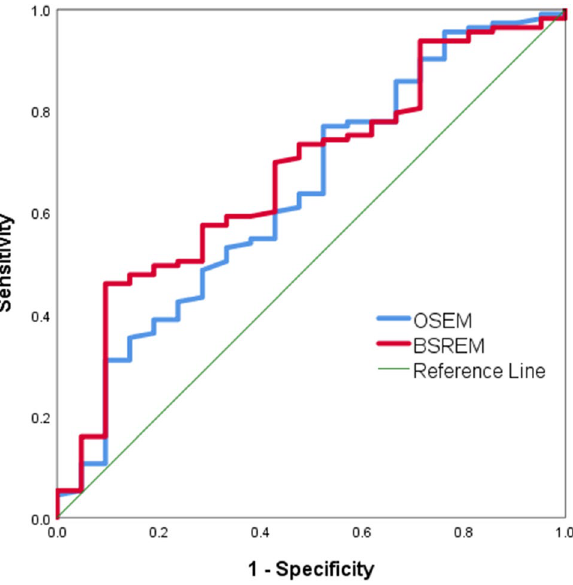
Figure 6. ROC curves for assesment of pulmonary nodules on OSEM and BSREM based on SUV max as a single determinant of malignant